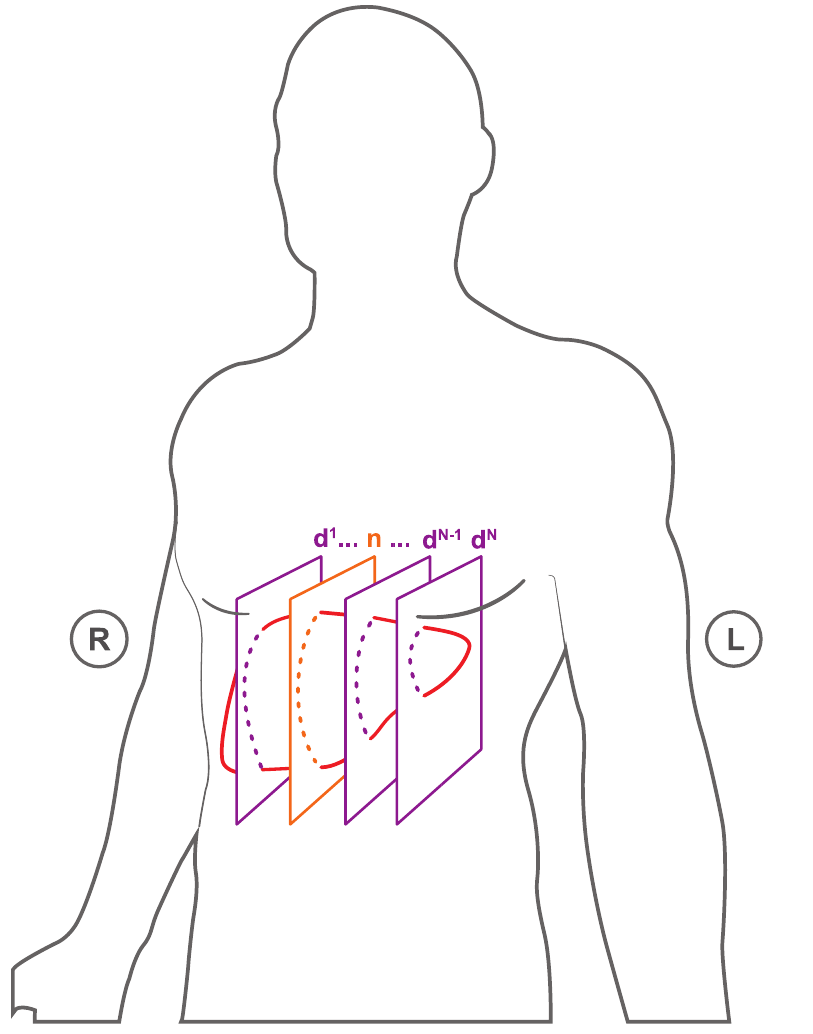
Fig 3. Schematic depiction of slice positions capturing the target volume. Slices are in sagittal orientation. The position of the navigator slice is the same for all sequences per subject. The slice positions for the data frames are distinct and correspond to different interleaved sequences from the 1’st to the N’th. Interleaved sequences are acquired from right to left.